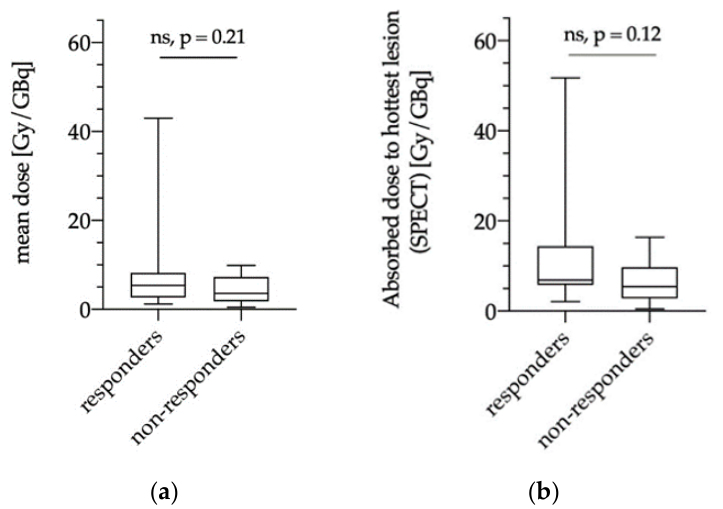
Figure 4. Comparison of mean absorbed doses in biochemical responders and non-responders using SPECT dosimetry for averaged tumor lesions on a patient-level (“mean dose”, ( a )) and for a single lesion with highest uptake (“hottest lesion”, ( b )) in the index-lesion-based dosimetry method. ns = not